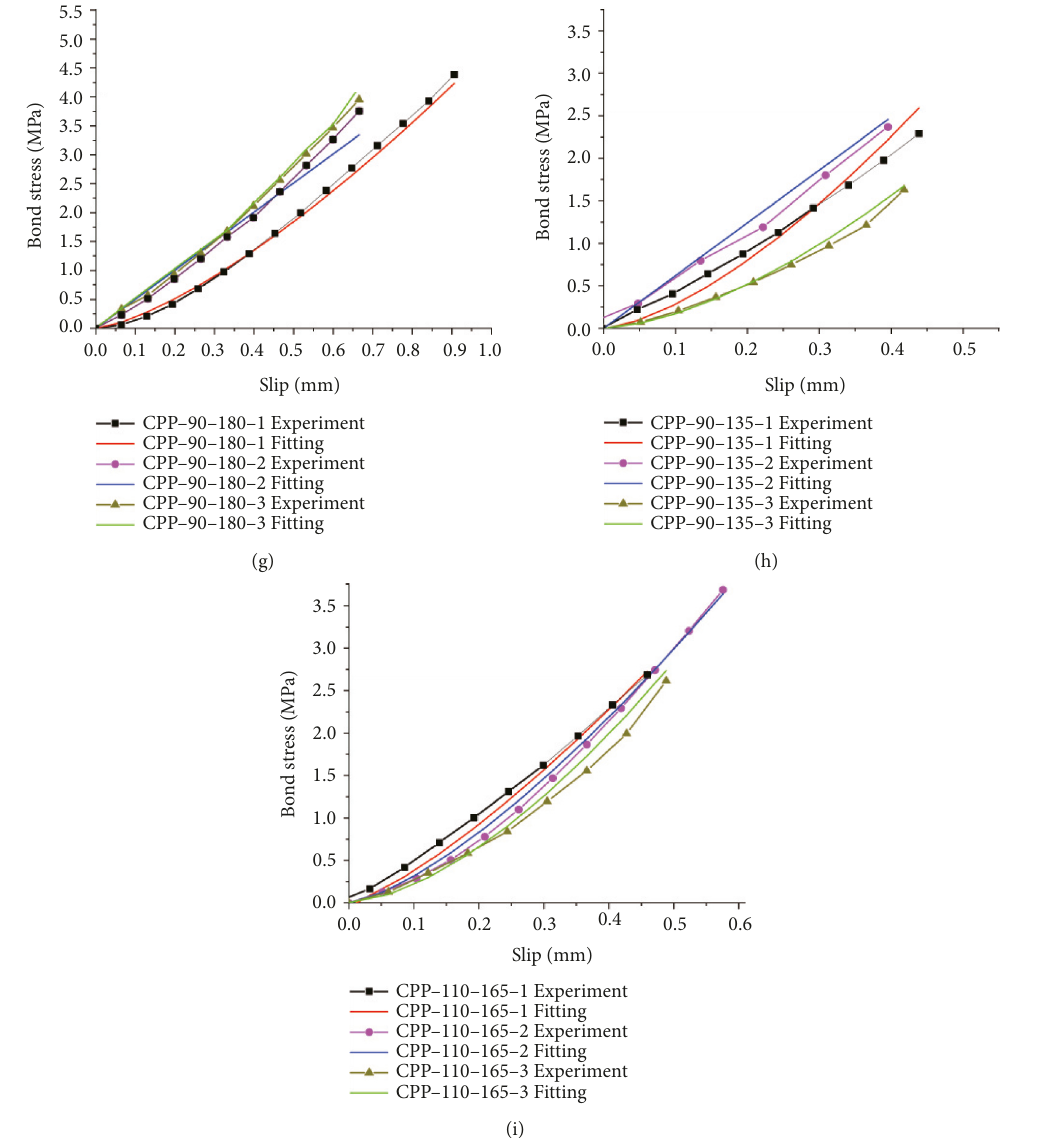
Figure 14: Comparison of theoretical results and fitting curves. (a) Cpp-90-135, (b) CMP-90-135, (c) REP-90-135, (d) CPP-FTC-10-135, (e) CPP-FTC-20-90-135, (f) CPP-90-90, (g) CPP-90-180, (h) CPP-80-112, (i)